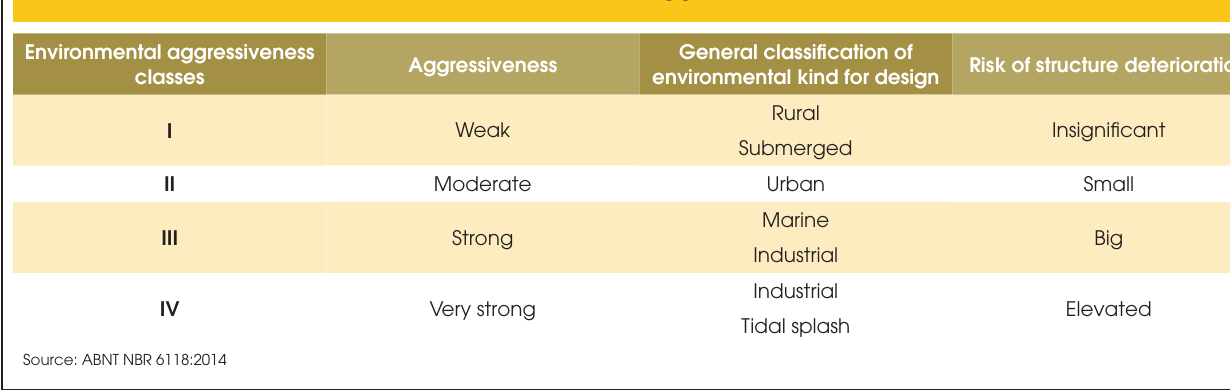
Table 2 – Environmental aggressiveness